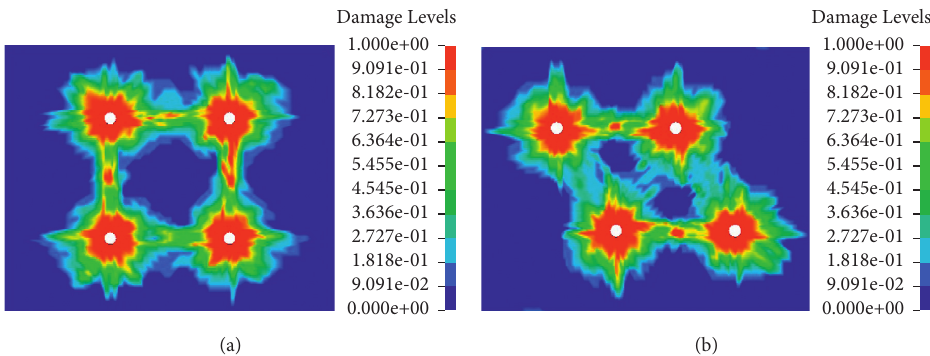
Figure 7: Near-zone damage nephogram of blasting models with different hole arrangements. (a) Rectangle. (b) Triangle.